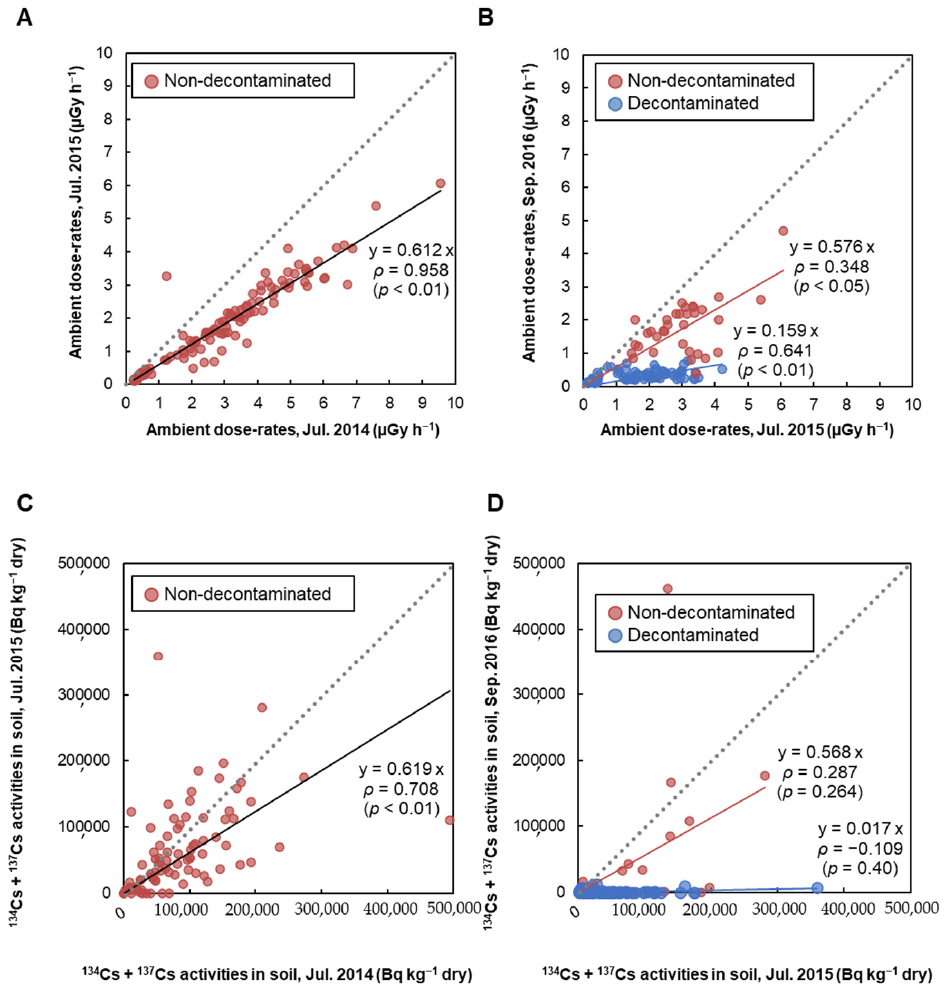
Figure 2. Ambient dose-rates and 134 Cs + 137 Cs activity concentrations in soil. Comparison of ambient dose-rates measured in ( A ) 2014 vs. 2015, ( B ) 2015 vs. 2016, and of 134 Cs + 137 Cs activity concentrations in soil measured in ( C ) 2014 vs. 2015, ( D ) 2015 vs. 2016. Red and blue circles represent areas that are non-decontaminated and decontaminated, respectively. Decontamination work in our research location in Namie Town started from September